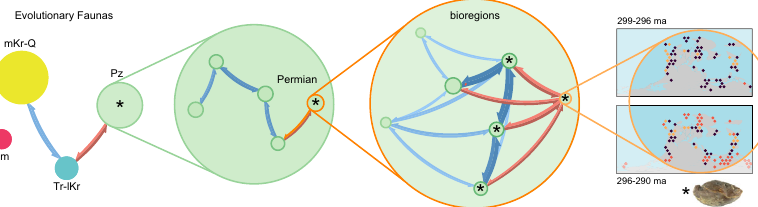
Fig. 5 A macroevolutionary hierarchy for future research. This visual representation shows the nested hierarchical structures in the reference solution (Supplementary Data 3). Modular structures at the higher level of organization in this macroevolutionary hierarchy correspond to evolutionary faunas, which are build up from lower levels entities, including sub-faunas, evolutionary bioregions, and taxa. Note that elements in this representation does not represent nodes from the original network but emergent structures and dynamics. COMMUNICATIONS BIOLOGY| (2021) 4:309